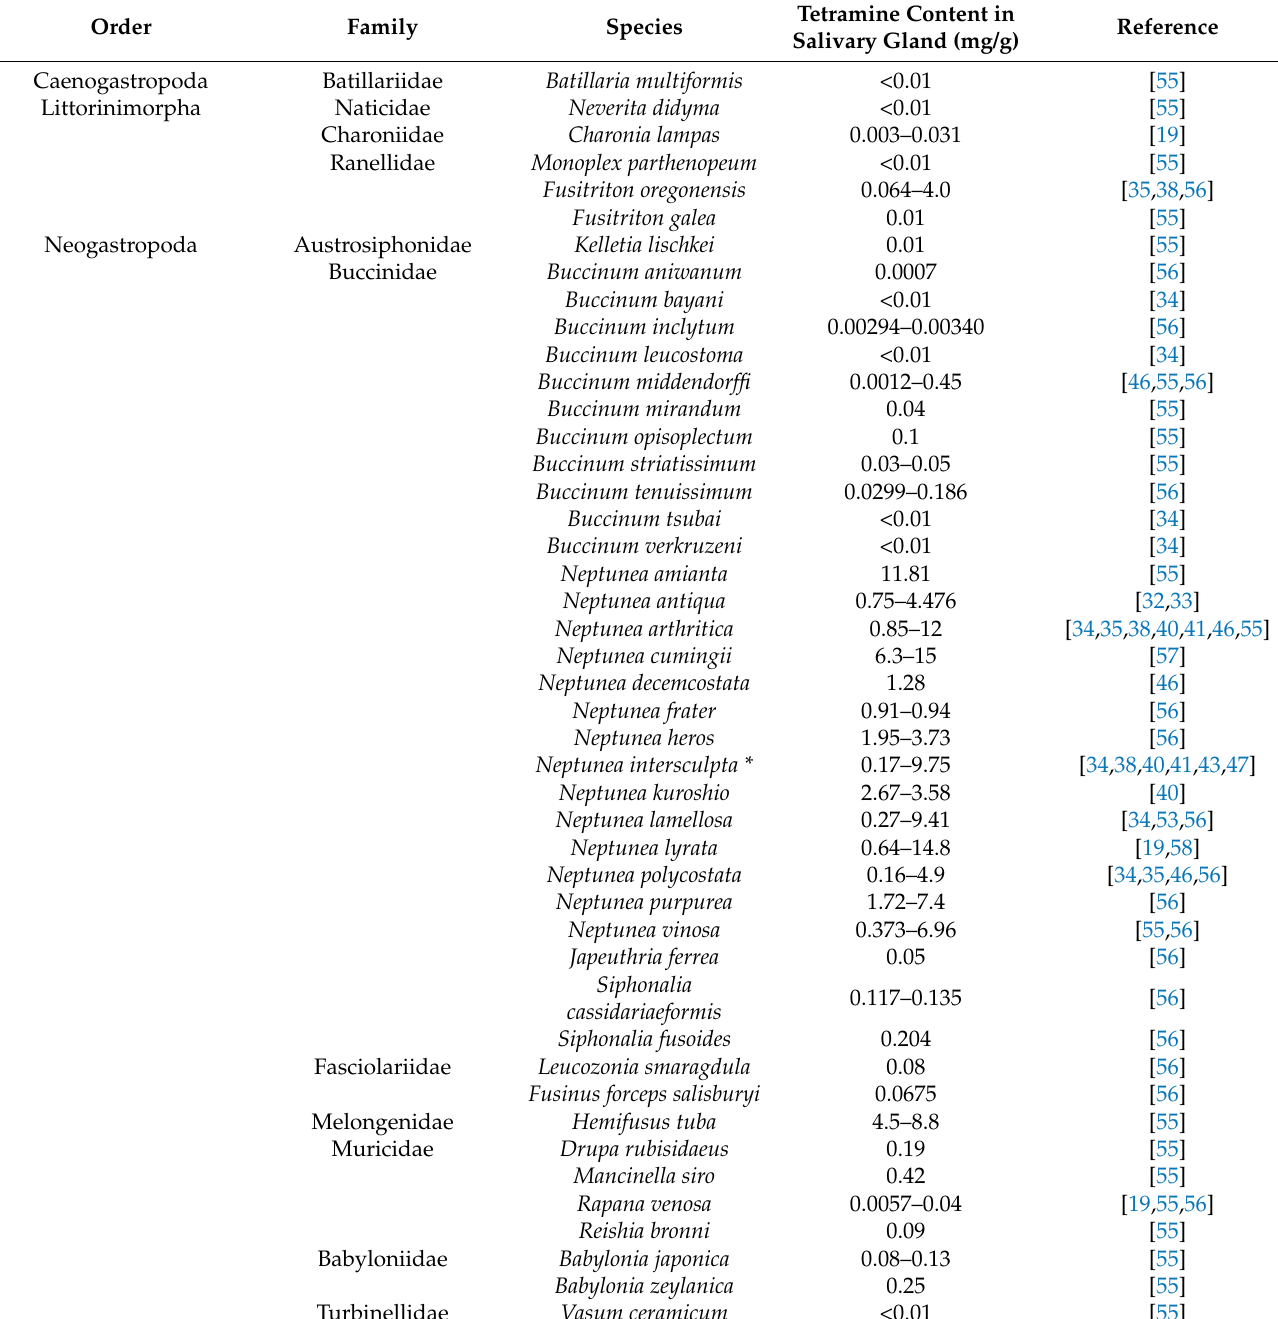
Table 2. Tetramine contents in the salivary glands of marine